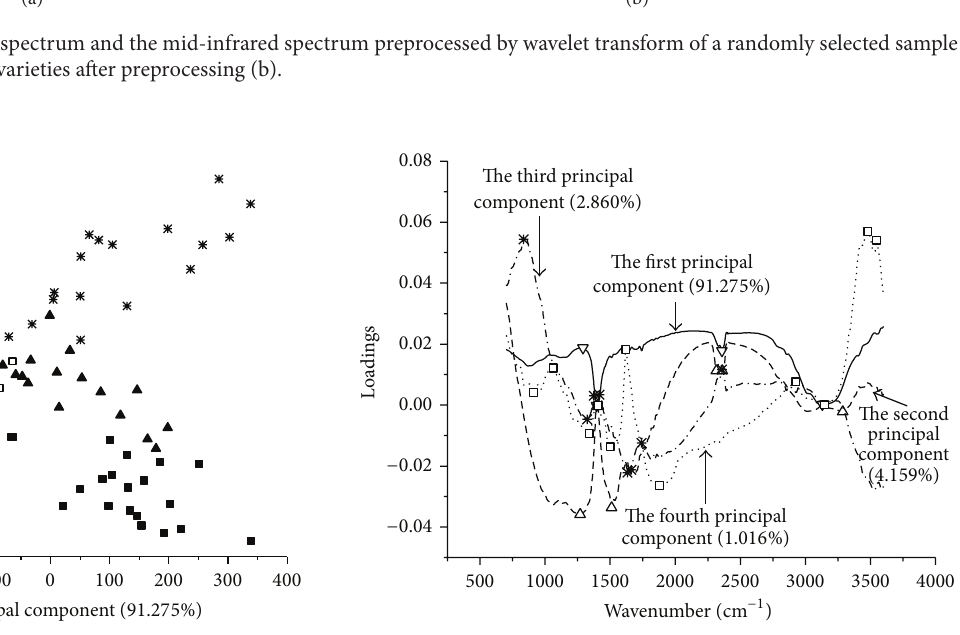
Figure 3: Wavenumbers selected by principal component analysis loadings (the marks ( △ , ◻ , ∗ , and ∇ ) referred to the selected wavenumbers of each